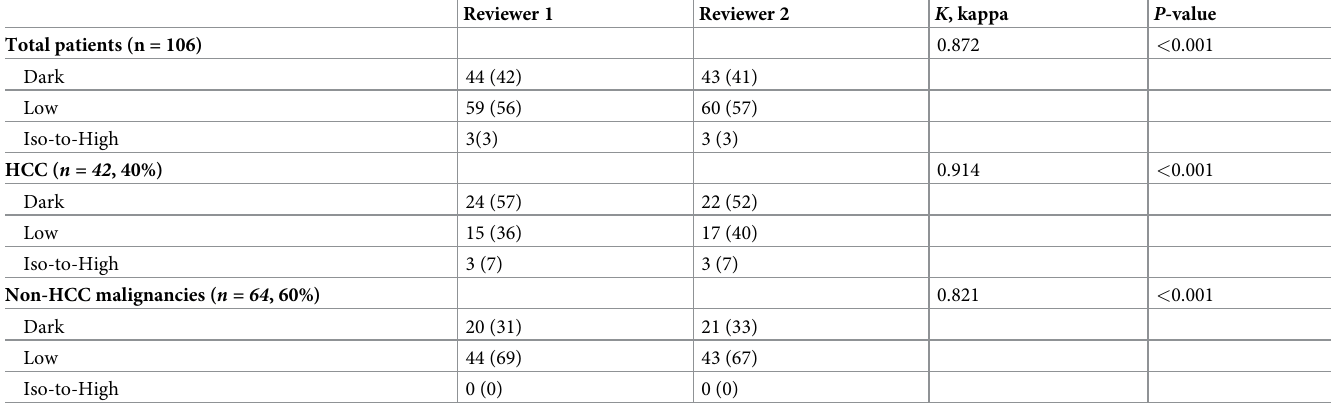
Table 5. Inter-reader agreement of HBP signal